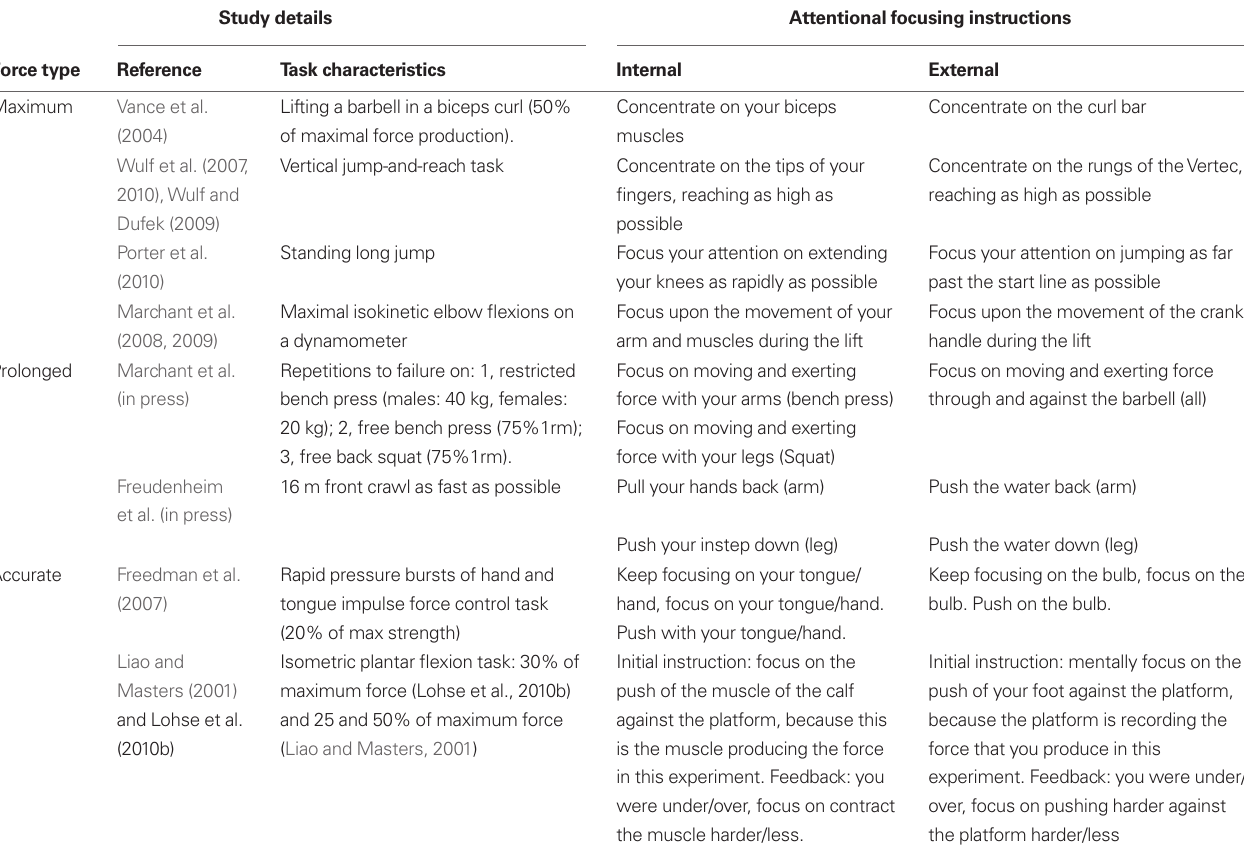
Table 1 | Attentional focusing instructions used in muscular force production